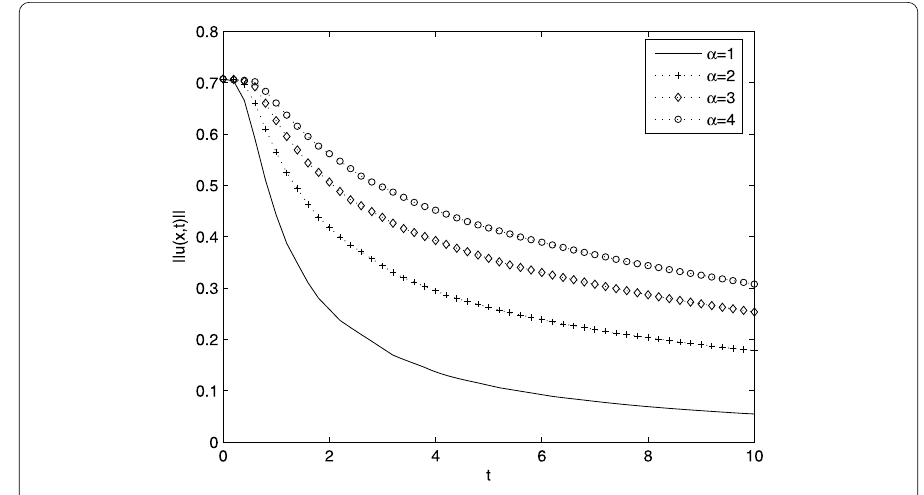
Figure 14 The L 2 -norm of u ( x , t ), (cid:7) u ( x , t ) (cid:7) , versus time for various values of α without control;